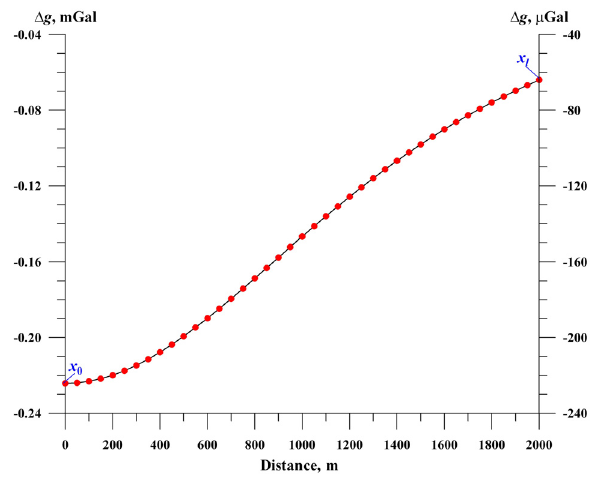
Figure 5. A distribution of gravity effect between the x 2000